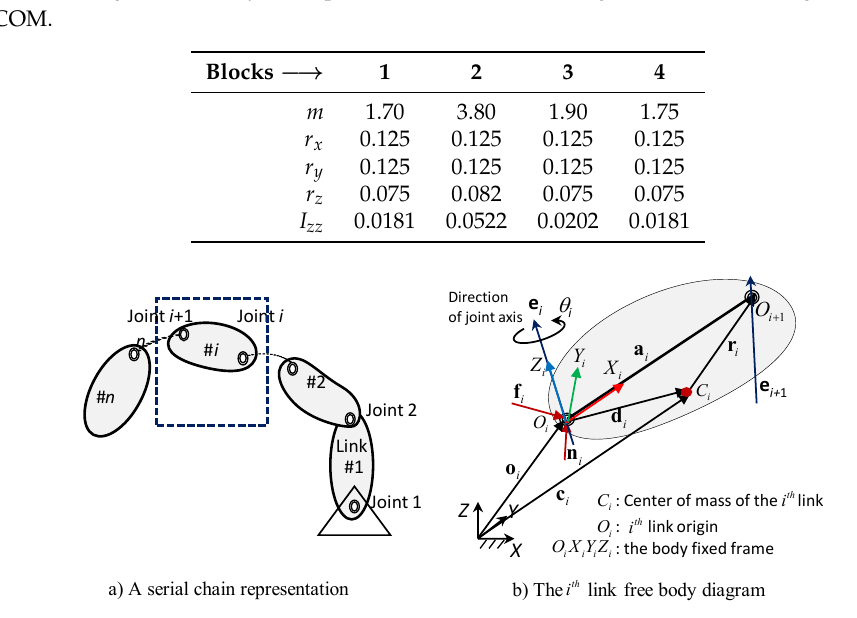
Figure 6. Free body diagram for i th-link in serial chain